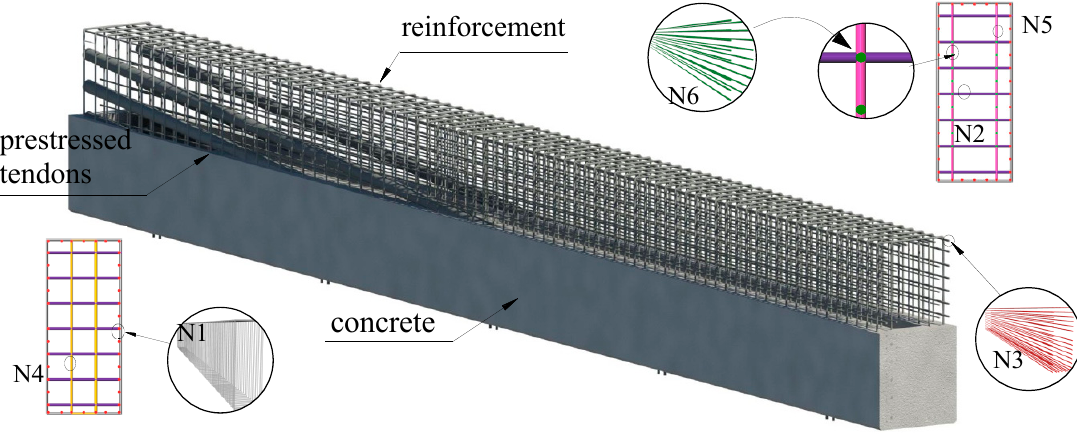
Figure 1. Detailed dimensions of the specimen (unit: mm): ( a ) Front of elevation; ( b ) sectional view.